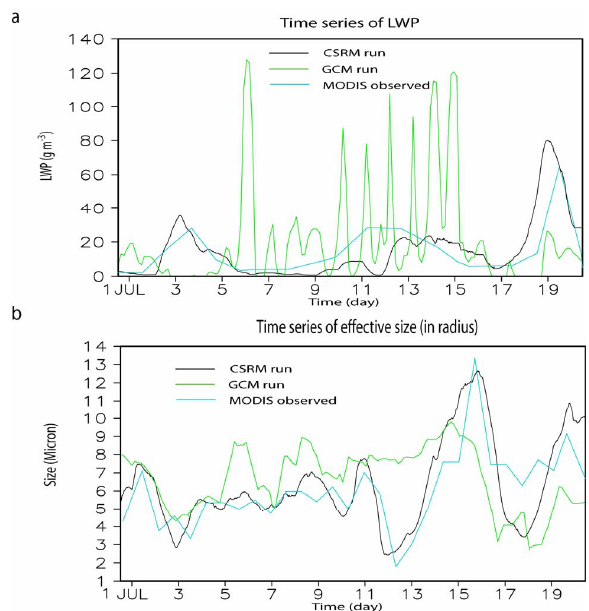
Fig. 8. Time series of (a) LWP (gm − 3 ) averaged over the horizon- tal domain and (b) effective radius (micron) conditionally averaged over the cloudy regions for the CSRM run, the GCM run, and the MODIS observation.